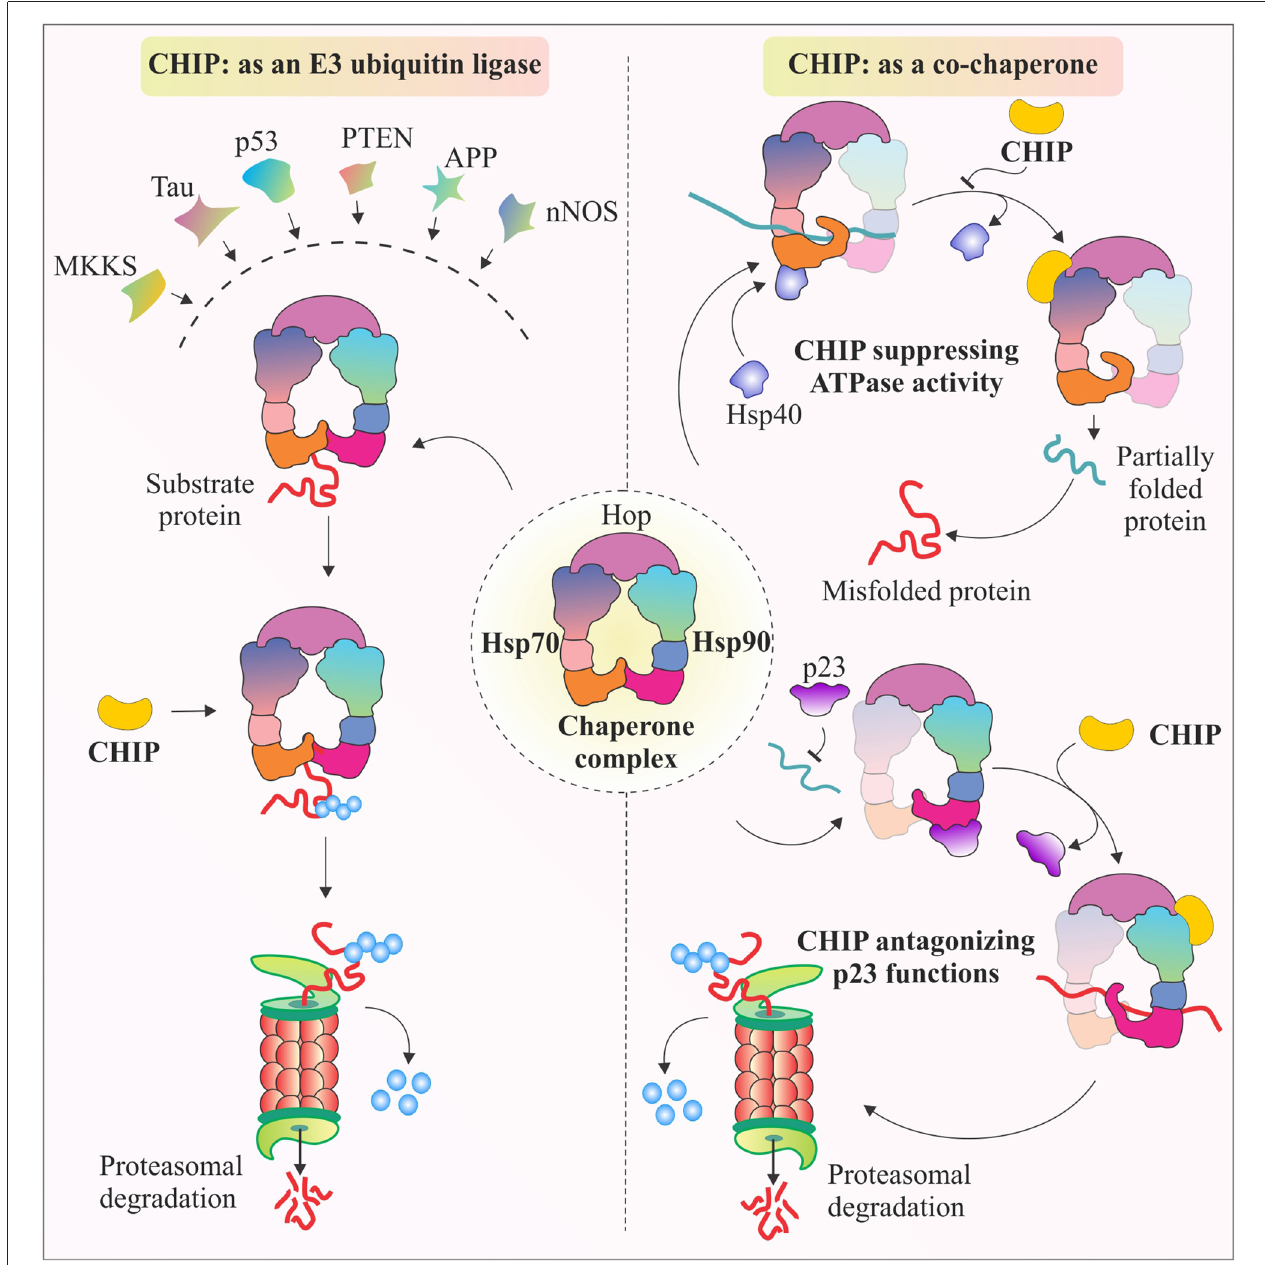
FIGURE 2 | Multifaceted CHIP, functions as E3 ubiquitin ligase and co-chaperone. The illustration represents E3 ubiquitin ligase activity of CHIP through which, it targets major class of its client proteins, when they are bound to Hsp70-Hsp90 chaperone complex. It ubiquitinates these proteins to tag them for proteasomal degradation. CHIP is also known for its co-chaperone like functioning. The figure also represents antagonistic effects of CHIP against co-chaperones Hsp40 and p23. CHIP antagonizes Hsp40 by inhibiting its ATPase activity which helps Hsp70 to fold its substrates (McDonough and Patterson, 2003). Similarly, CHIP binds with Hsp90, causing release of p23, resulting in ubiquitination and further degradation of substrate proteins, such as glucocorticoid receptors (GR) and erythroblastic leukemia viral oncogene homolog 2 (ErbB2; Connell et al., 2001; Höhfeld et al., 2001; Xu et al., 2002; Theodoraki and Caplan,